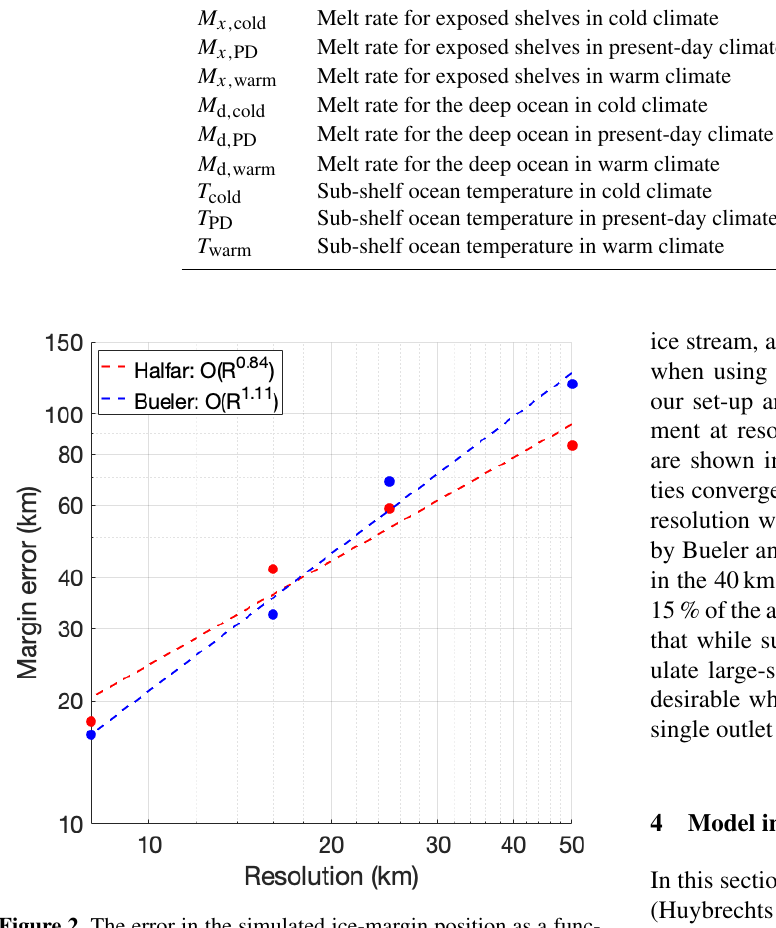
Figure 2. The error in the simulated ice-margin position as a func- tion of horizontal model resolution for the Halfar and Bueler dome